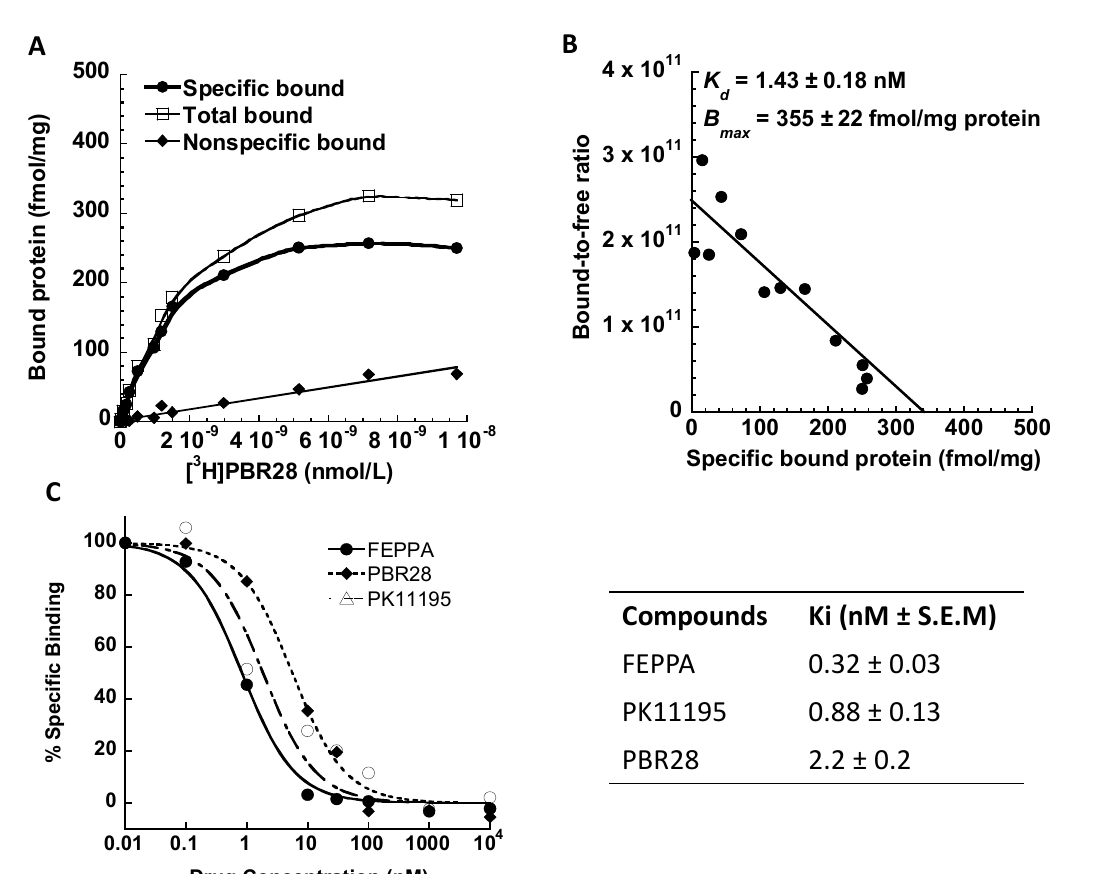
Figure 2. Scatchard analysis and pharmacological profile of [ 3 H]PBR28 binding to PBR in rat brain membrane homogenates. ( A ): Representative saturation binding experiment which shows the total bound, nonspecific bound and specific bound. ( B ): Representative Scatchard plot of the K d (1.43 ± 0.18 nM) and B max (355 ± 22 fmol/mg protein). ( C ): Representative competitive binding data for inhibition of [ 3 H]PBR28 binding to PBR in rat brain by known PBR ligands FEPPA ( K i = 0.32 ± 0.03 nM), PK11195 ( K i = 0.88 ± 0.13 nM) and PBR28 ( K i = 2.2 ± 0.2 nM). The values are the mean ± S.E.M for n = 3 determinations, samples in duplicate.